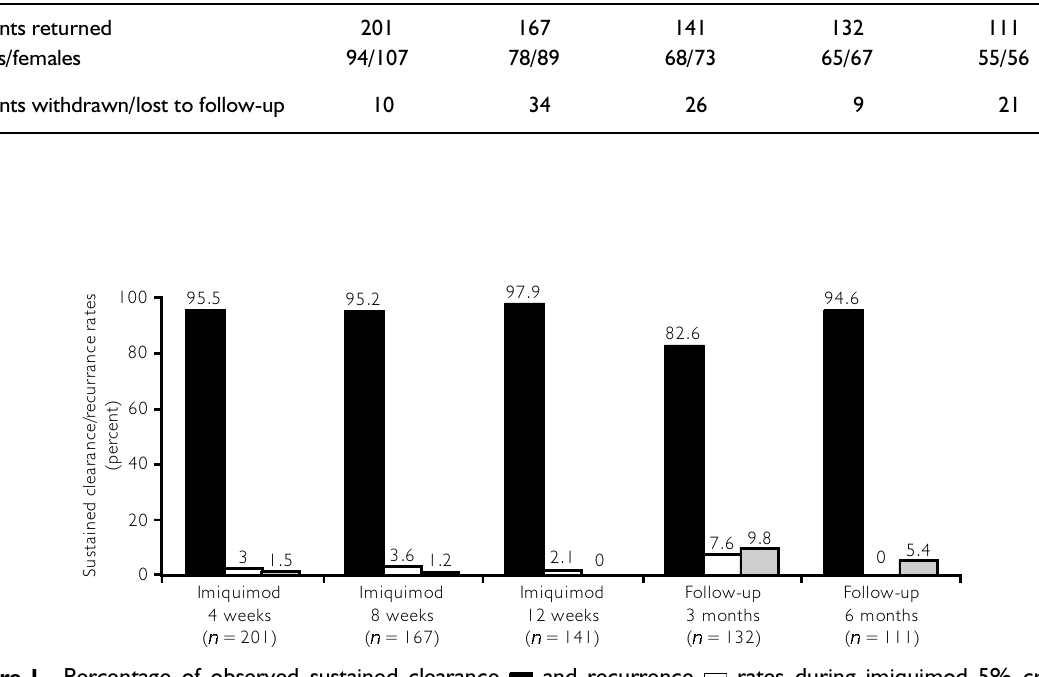
Figure 1 Percentage of observed sustained clearance and recurrence rates during imiquimod 5% cream treatment and treatment-free follow up (missing